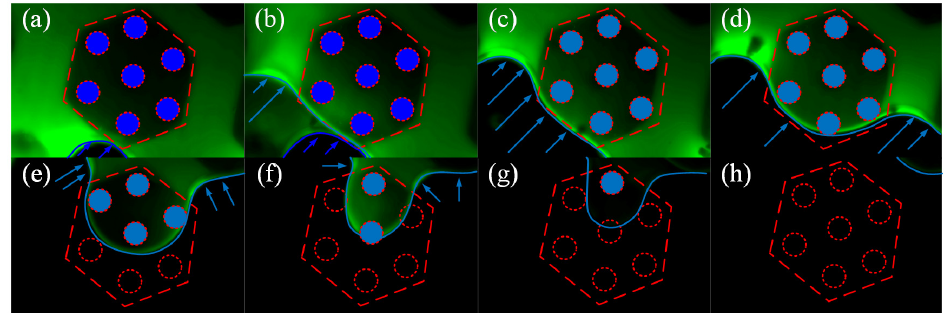
Figure 11. Migration process of liquid film in a single hierarchical microstructure unit: ( a ) The hierarchical fibril was submerged by the liquid film; ( b ) The liquid film began to separate into the primary and secondary layers. The light blue arrow represents the secondary liquid layer bound- ary, and the dark blue arrow represents the primary liquid layer boundary; ( c – g ) Secondary liquid film migrated over a single hierarchical fibril; ( h ) A single hierarchical fibril was totally peeled away from the substrate.